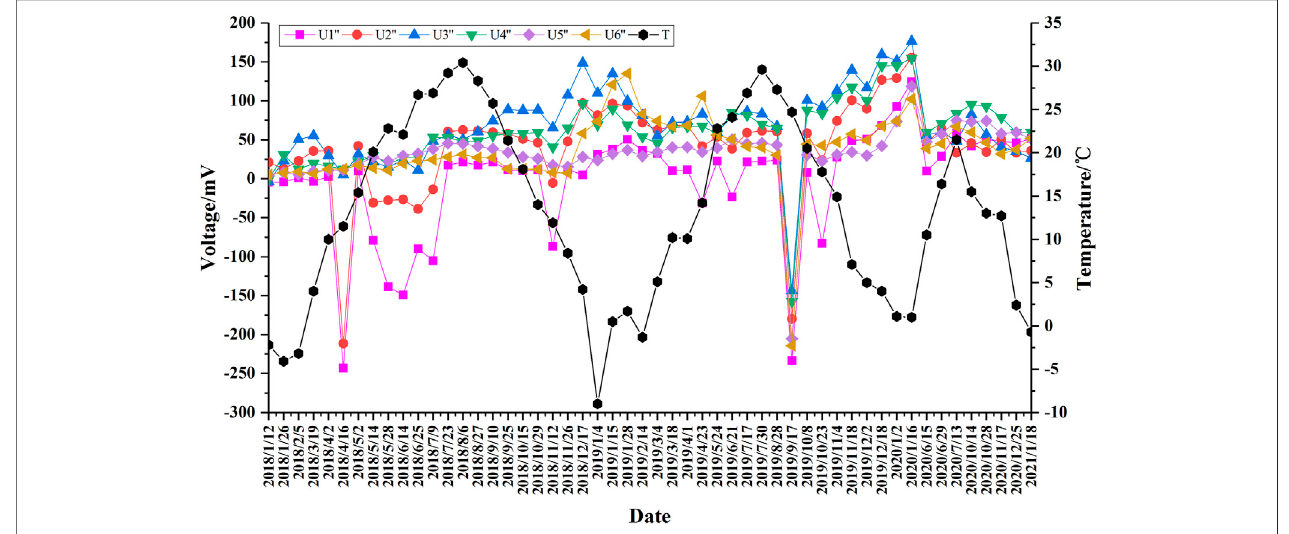
FIGURE 10 | Voltage between anode and reinforcement-connection.